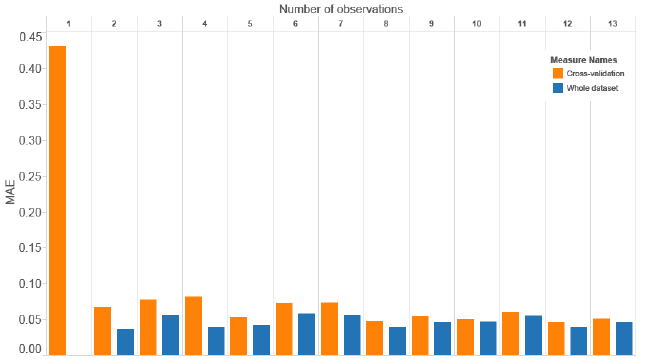
Figure 6. Impact of the number of data points on the quality